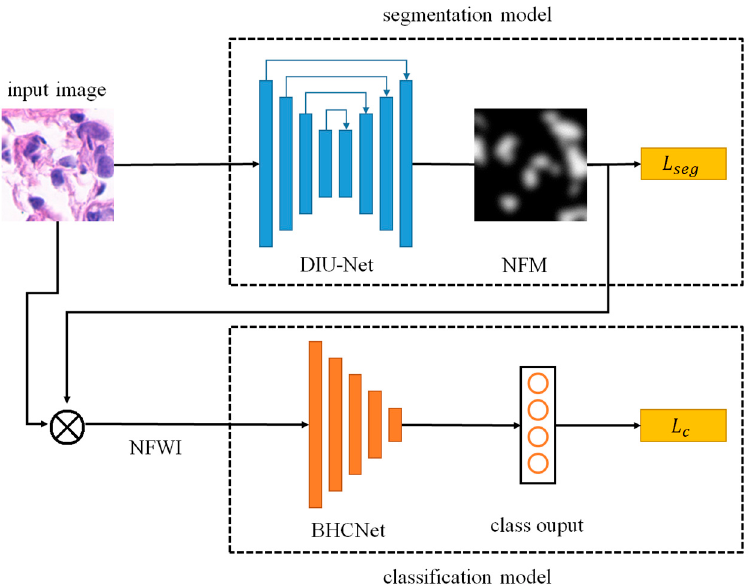
Figure 1. System architecture of the proposed method. For the binary classification case, the class output corresponds to benign/malignant, while for the multi-classification case, the class output corresponds to the eight subcategories.